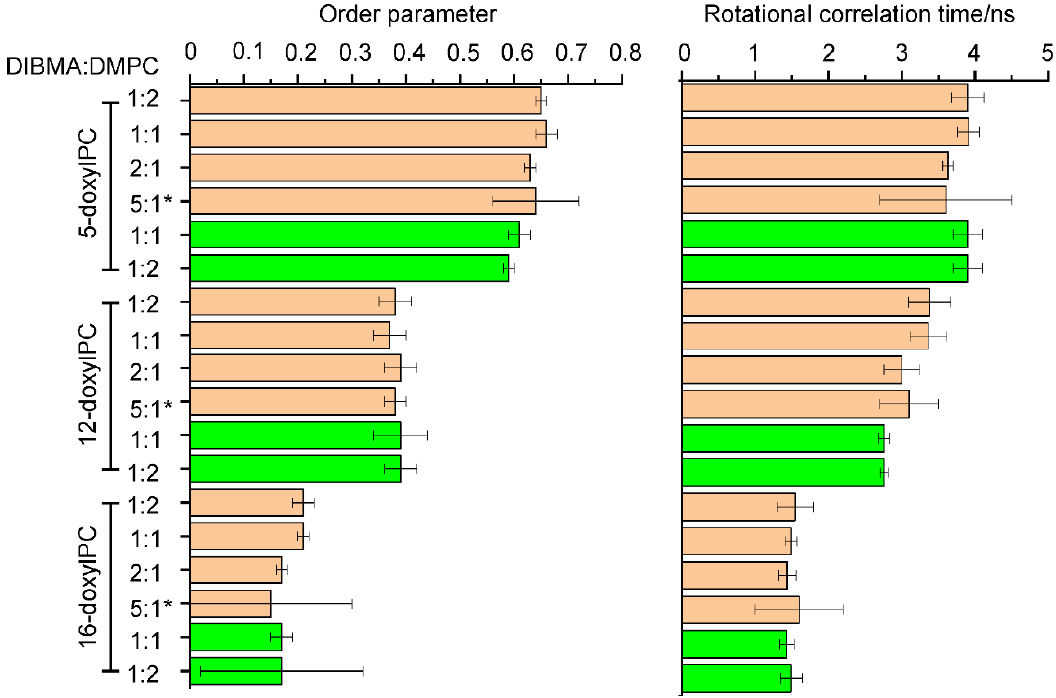
Figure 5. Order parameter S and rotational correlation time τ calculated from the fits of the spectra shown in Figure 4 for empty (brown) and Np SRII containing (green) DIBMALPs. * For comparison, the values for empty DIBMALPs prepared with a concentration ratio of 5:1 are given (taken from [45]).